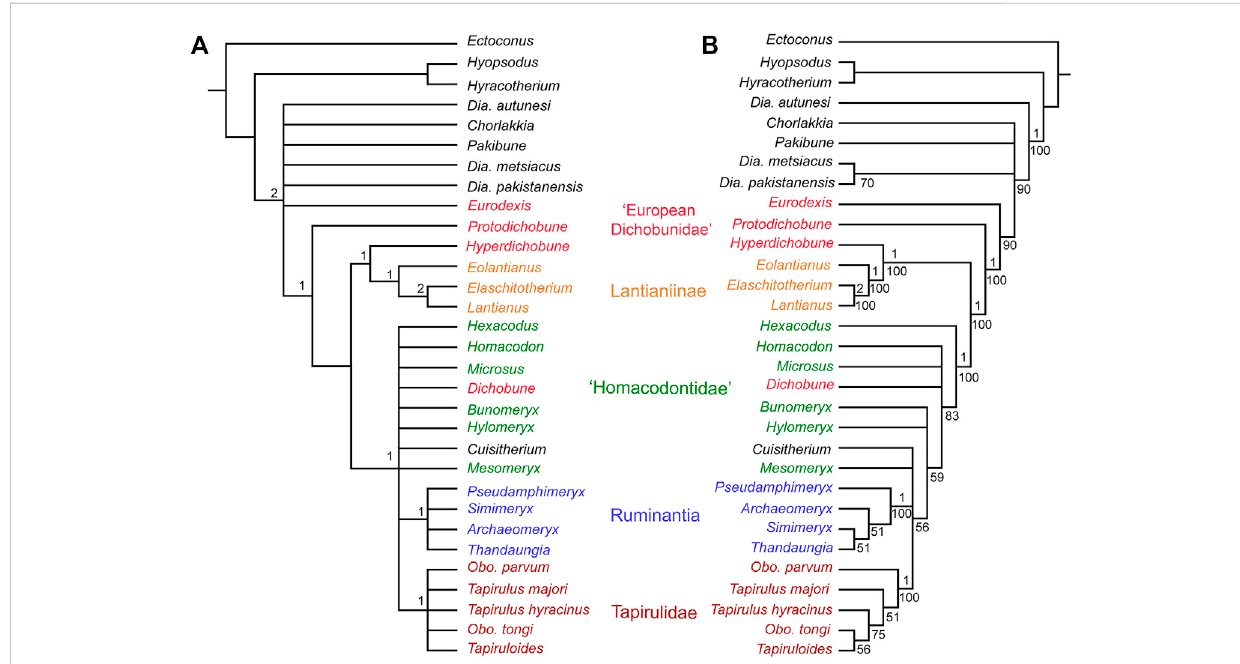
FIGURE 9 Strict consensus (A) and 50%majority-ruleconsensus (B) trees ofthe124 MPTsinthephylogeneticanalyses oftheearlyartiodactyls withafocuson Tapirulidae. Values above the branches are Bremer Support at the nodes, and below the branches are the percentage of 50% majority-rule consensus